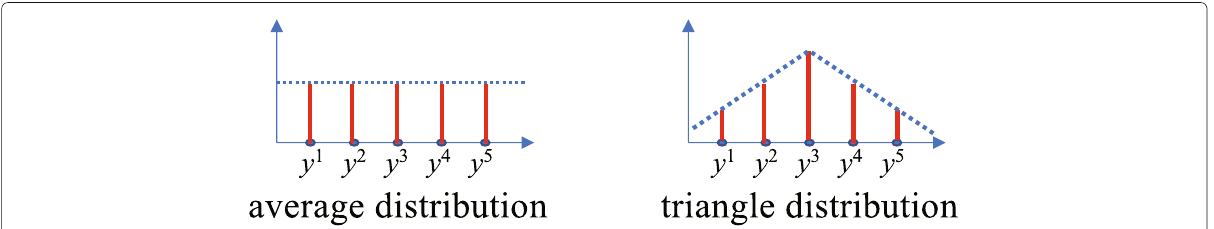
Fig. 7 The different label distributions: average distribution and triangle distribution